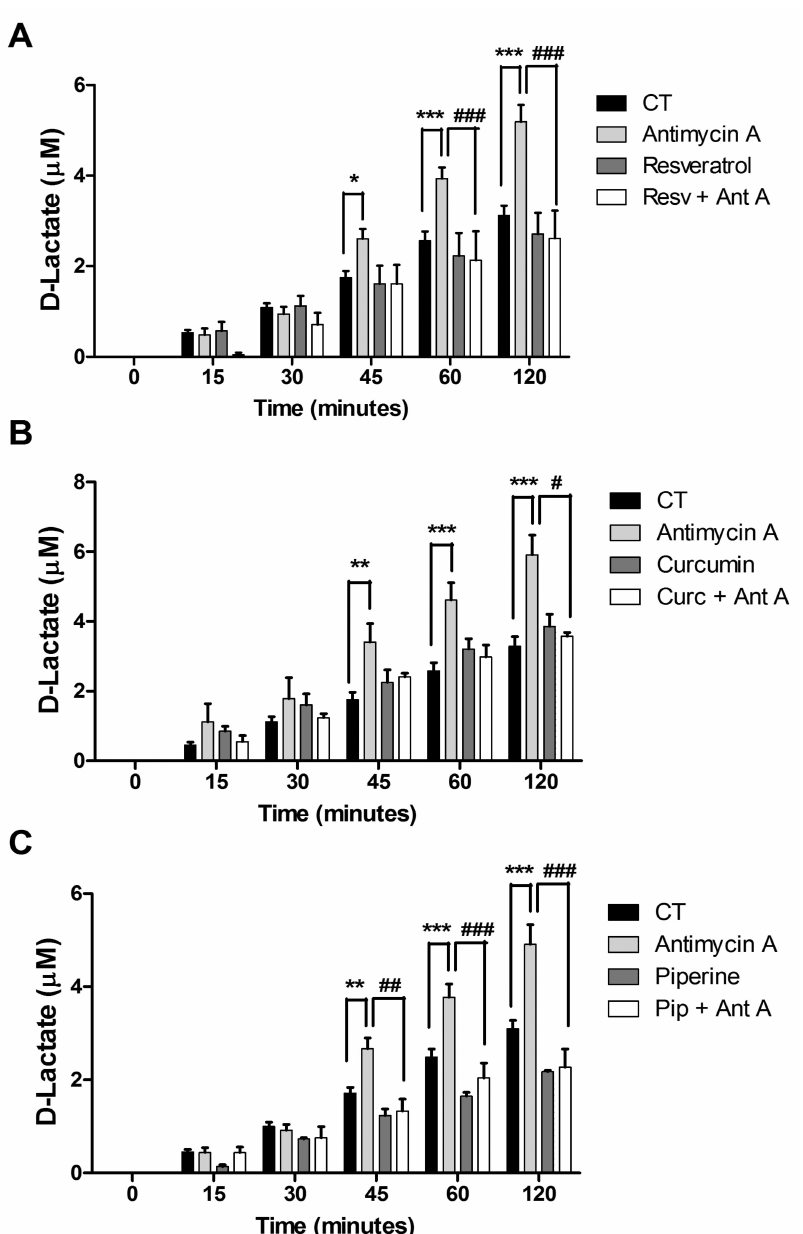
Figure 5. D-Lactate production in MCF-7 cells after resveratrol, curcumin and piperine treatment: Cells were treated with 131.0 µ M resveratrol ( A ), 24.5 µ M curcumin ( B ) or 94.5 µ M piperine ( C ) for 24 h. After treatment, medium aliquots were collected at 0, 15, 30, 45, 60 and 120 min and incubated in a hydrazin bu ff er, pH 9.2, with NAD + and lactate dehydrogenase (LDH) for released lactate measurement. Antimycin A at 2 µ g / mL was used as a positive control. The results are representative of three experiments performed in triplicate ± SEM. * p < 0.05, ** p < 0.001, and *** p < 0.0001 in relation tothe control. # p < 0.05, ## p < 0.001, and ### p < 0.0001 in relation to antimycin. Resv = Resveratrol, Curc = Curcumin, PIP = Piperine, Ant A = Antimycin